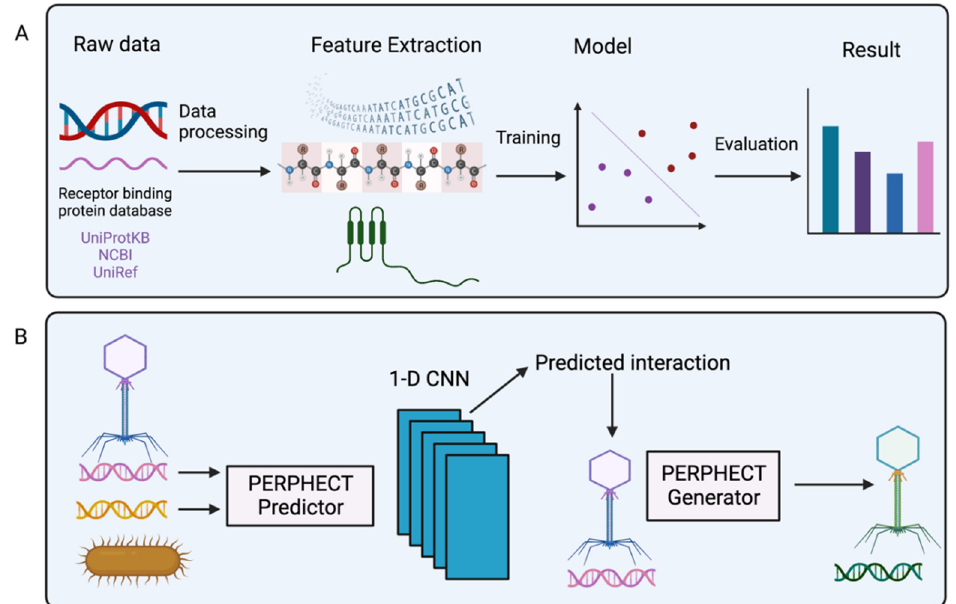
Figure 5. Schematic representation of the machine learning model. ( A ) The raw data (DNA and RNA sequences) of the receptor binding protein database are used to extract features. Next, the features are fitted into different machine learning models, which are evaluated to predict the best result. ( B ) Representation of PERPHECT model; phage and bacterial genetic information are used by the PERPHECT model and PERPHECT generator to provide guidance for genomic modification of the existing phage [109]. Created by BioRender.com.